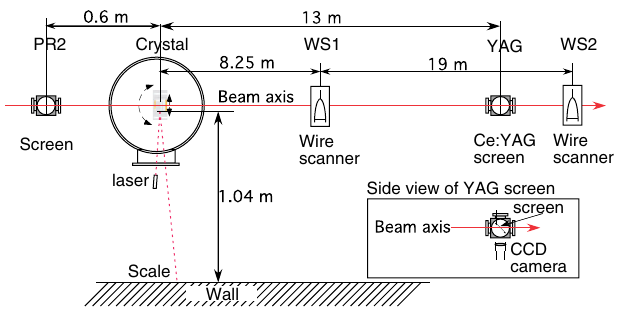
FIG. 3. A sketch of the experimental